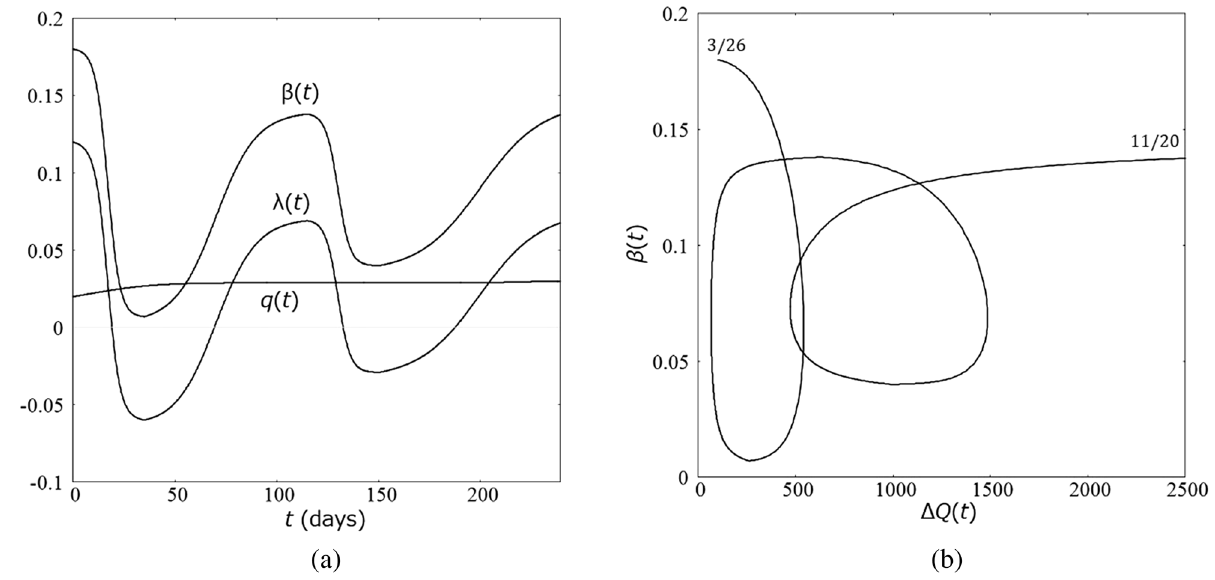
t − t 2i + 1 + B is set to satisfy dt 2i + 1 (cid:31) (cid:30)